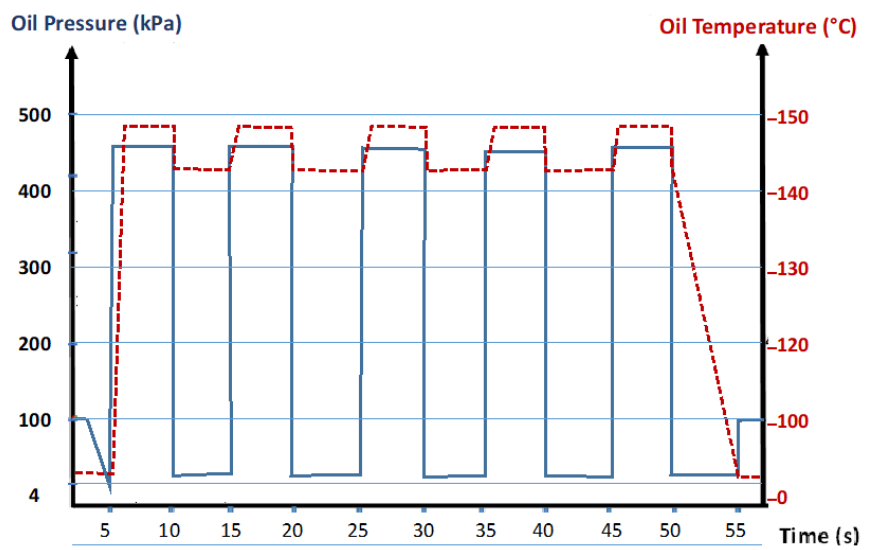
Figure 3. Pressure and Temperature Evolutions during MFA treatment (cycle time of 10 s; oil pressure of 450 kPa; oil temperature of 148 °C).